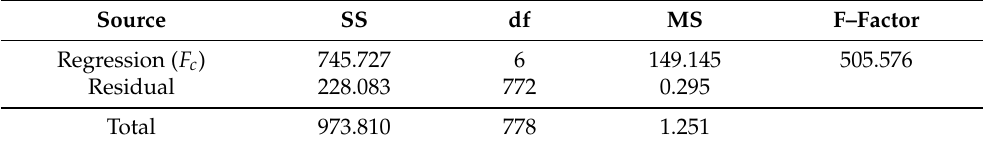
Table 6. Regression analysis for correlation of cutting force.